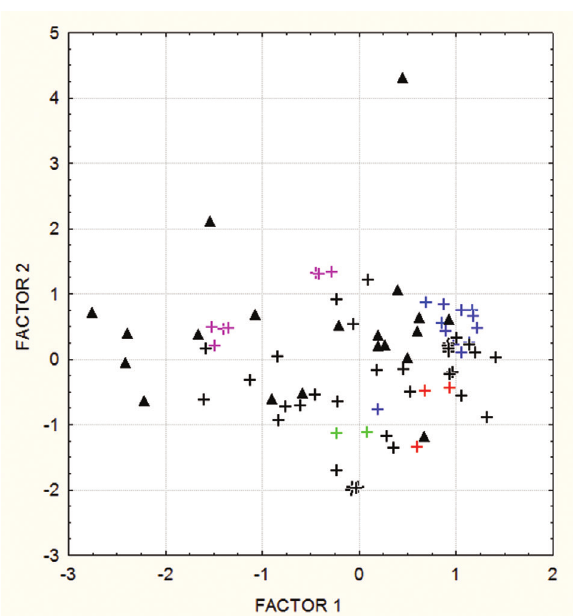
Figure 3. Representation of the climatic envelopes of P. riparia and its presumed synonyms in the prin- cipal plane of the PCA (same color code as for Figure 2). Passiflora ambigua collections are represented by black